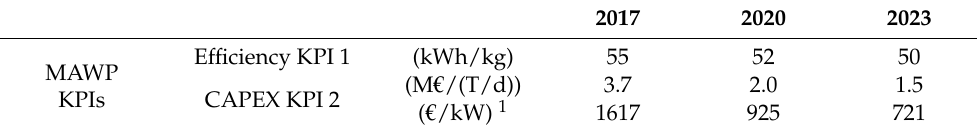
Table 14. Efficiency KPI 1 and Capex KPI 2 (MAWP, FCH JU).